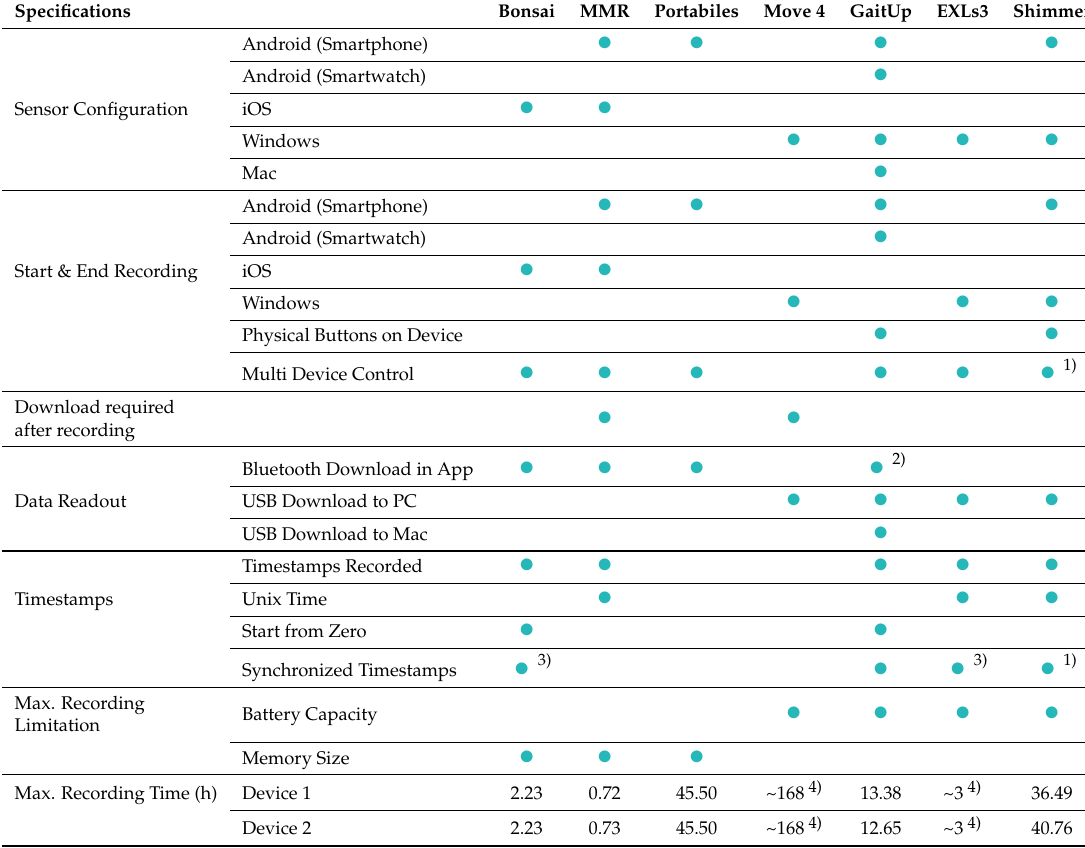
Table 7. Data collections